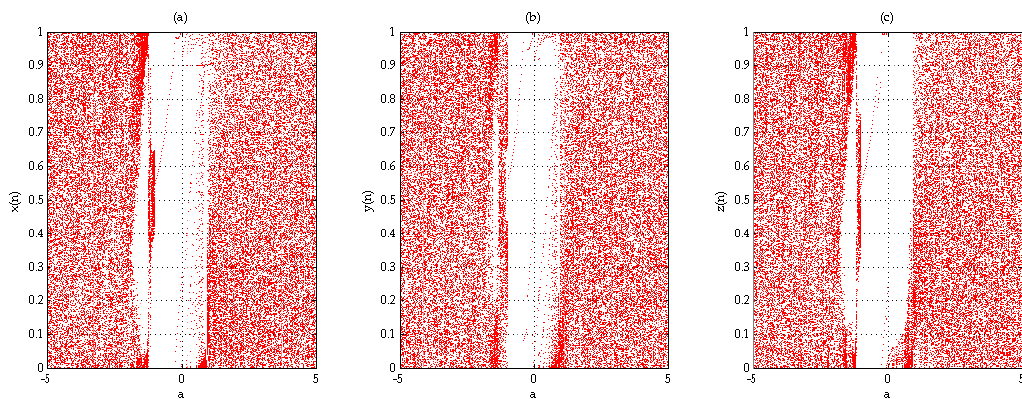
Figure 12. Three-dimensional bifurcation diagram of system (3): ( a ) a-X bifurcation diagram; ( b ) a-Y bifurcation diagram; ( c ) a-Z bifurcation diagram.